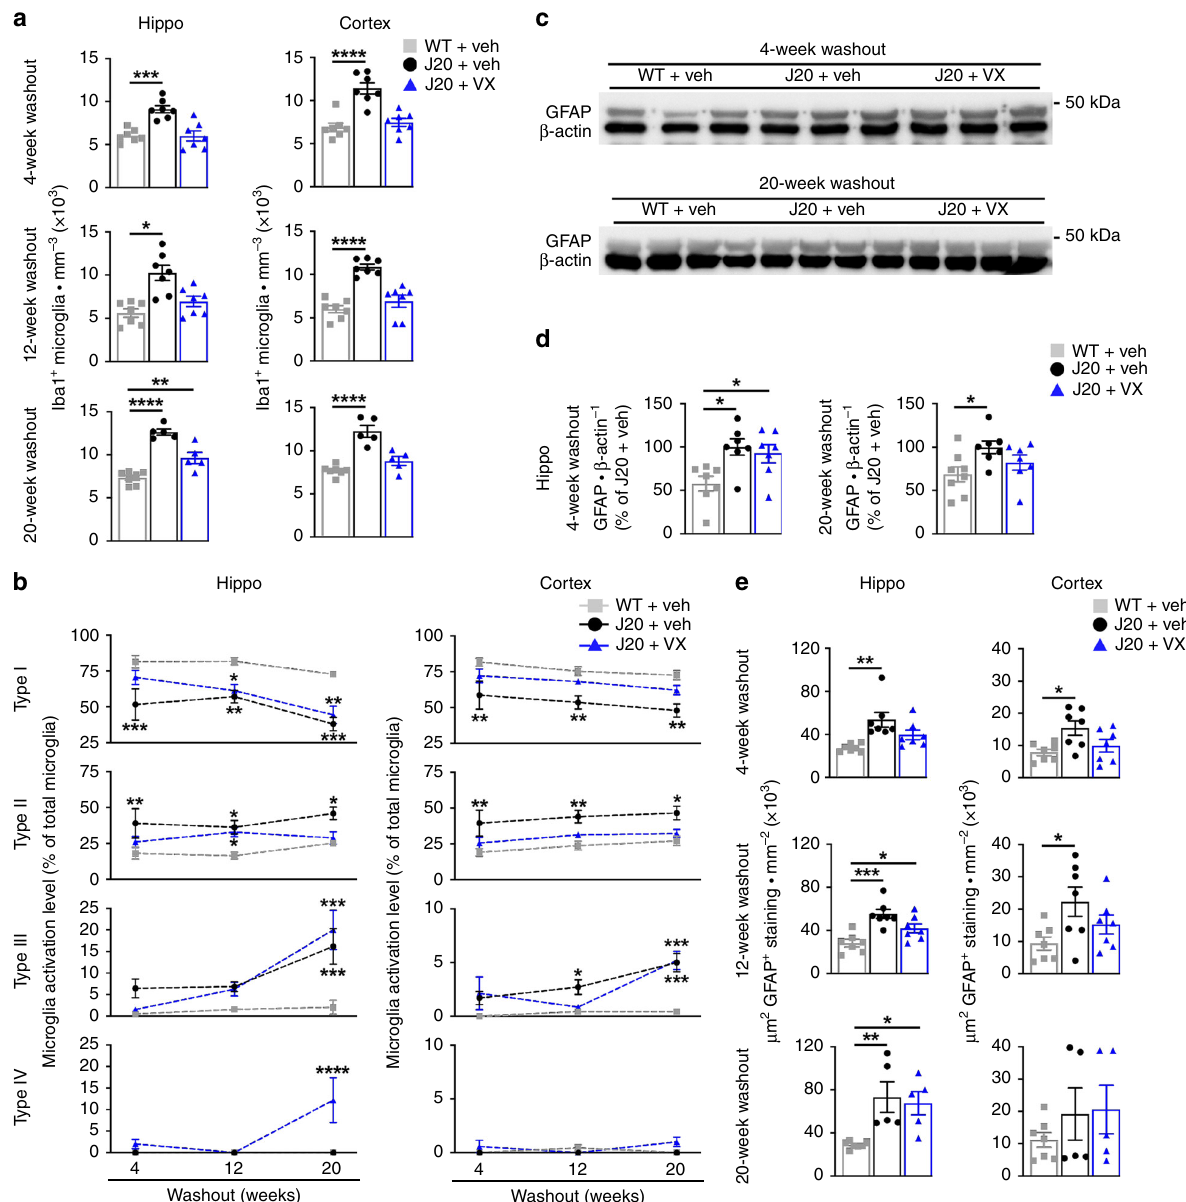
Fig. 4 Pre-symptomatic VX-765 treatment decreases Iba1-positive microglial in fl ammation in J20 mice. a Iba1-positive microglial quanti fi cation of vehicle-treated WT and J20, and VX-765-treated J20 mice from the pyramidal cell layer to the SLM in the hippocampal CA1 [hippo 4-week WO F(2,18) = 16.42, p = 8.74 × 10 − 5 ; hippo 12-week WO F(2,18) = 12.25, p = 0.0004; hippo 20-week WO F(2,14]) = 40.35, p = 1.54 × 10 − 6 ] and cortical retrosplenial and S1 area [cortex 4-week WO F(2,18) = 20.53, p = 2.27 × 10 − 5 ; cortex 12-week WO F(2,18) = 25.82, p = 5.14 × 10 − 6 ; cortex 20-week WO F(2,14) = 25.92, p = 1.96 × 10 − 5 , ANOVA, Dunnett ’ s post hoc compared to WT + vehicle]. b Mean percentage distribution of morphological microglial subtype I [hippo treatment interaction F(2,50) = 22.47, p = 1.09 × 10 − 7 ; across WO F(2,50) = 7.044, p = 0.0020; cortex treatment interaction F(2,50) = 16.96, p = 2.38 × 10 − 6 ], subtype II [hippo treatment F(2,50) = 12.37, p = 4.31 × 10 − 5 ; cortex treatment F(2,50) = 14.66, p = 9.78 × 10 − 6 ], subtype III [hippo treatment F(2,50) = 18.04, p = 1.26 × 10 − 6 ; WO F(2,50) = 19.50, p = 5.49 × 10 − 7 ; treatment × WO interaction F(4,50) = 5.098, p = 0.0016; cortex treatment F(2,50) = 14.37, p = 1.18 × 10 − 5 ; WO F(2,50) = 8.890, p = 0.005, treatment × WO interaction F(4,50) = 2.822, p = 0.0346, two-way ANOVA, Dunnett ’ s post hoc compared to WT + vehicle], and subtype IV (no signi fi cant difference). In ( a ) and ( b ), n = 7 mice per group at 4-week WO; n = 7 mice per group at 12-week WO; n = 7 WT + veh, 5 J20 + veh, 5 J20 + VX, mice at 20-week WO. c GFAP and β -actin western blot in the hippocampus of three independent mice at 4- and 20-week WO. d GFAP western blot quanti fi cation in the hippocampus at 4-week ( n = 7 mice per group) and 20-week ( n = 8 WT + veh, 7 J20 + veh, 7 J20 + VX mice). WO: [4-week WO F(2,18) = 5.577, p = 0.0130; 20-week WO F(2,19) = 3.629, p = 0.0463, ANOVA, Dunnett ’ s post hoc compared to WT + vehicle]. e GFAP positive immunostaining density in the hippocampal CA1 and retrosplenial and S1 cortex [hippo 4-week WO F(2,18) = 7.546, p = 0.0042; cortex 4-week WO F(2,18) = 4.571, p = 0.0248; hippo 12-week WO F(2,18) = 11.66, p = 0.0006; cortex 12-week WO F(2,18) = 3.723, p = 0.0443; hippo 20-week WO F(2,14) = 7.763, p = 0.0054, ANOVA, Dunnett ’ s post hoc compare to WT + vehicle]. Mouse numbers in ( e ) are the same as in ( a ). Data represents mean and s.e.m. * p < 0.05, ** p < 0.01, *** p < 0.001, **** p <